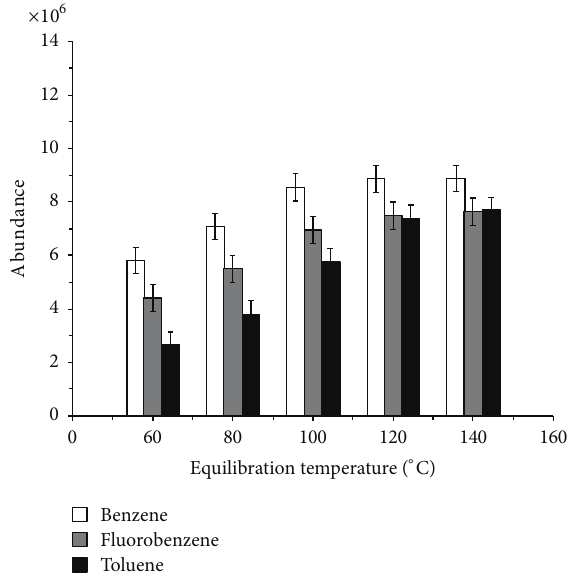
Figure 2: Effect of equilibration temperature on benzene, toluene, and IS peak abundance (equilibration time: